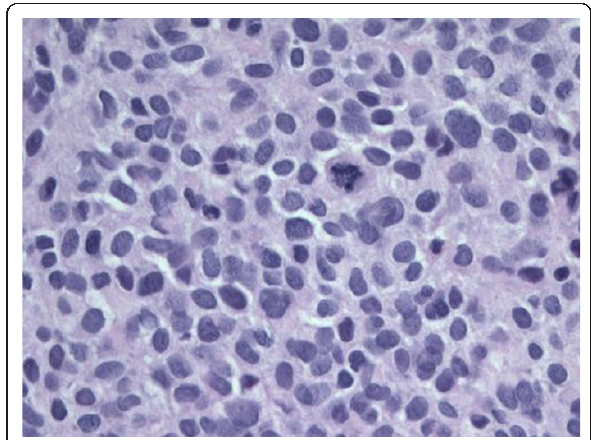
Figure 3 Microphotograph representative of the core biopsy material demonstrating a diffuse population of small